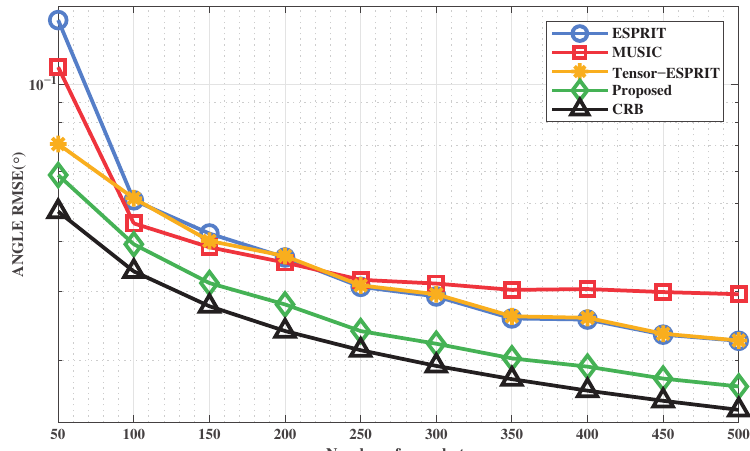
Figure 7. RMSE of DOA estimation versus L